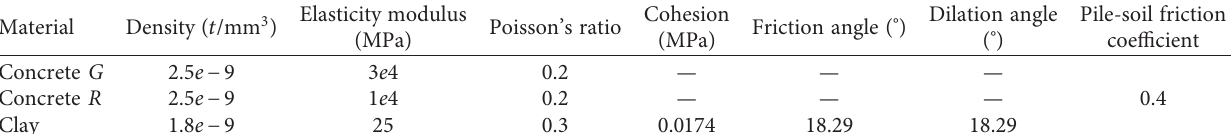
Table 1: Parameters of the pile and soil materials for numerical